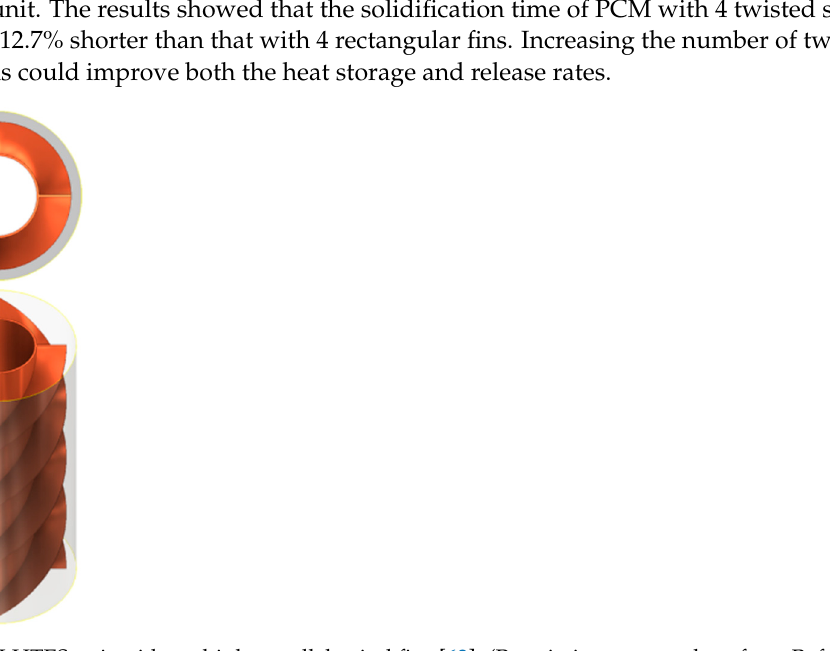
Figure 6. Different working conditions of LHTES unit with spiral fins [61]. ( a ) Shell exposed to air; ( b ) Shell slightly heated. (Permission to reproduce from Ref. [61]).